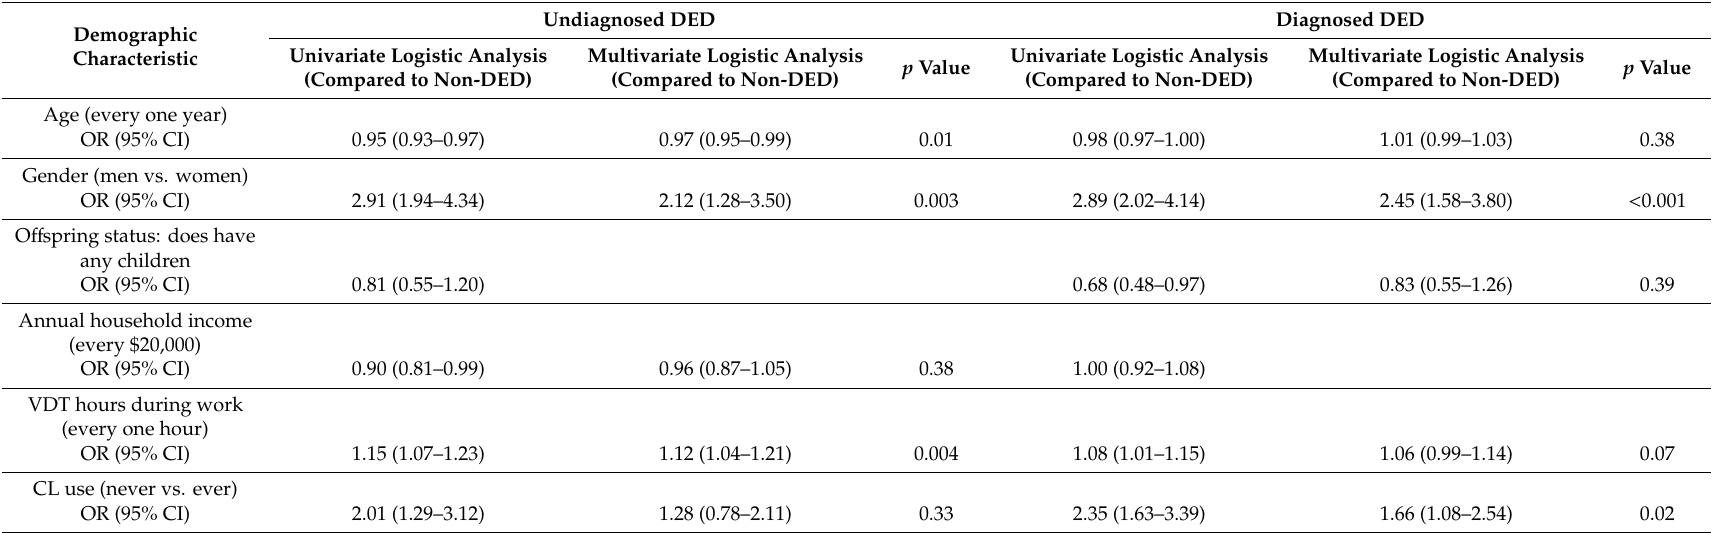
Table 3. Risk factors of undiagnosed and diagnosed dry eye